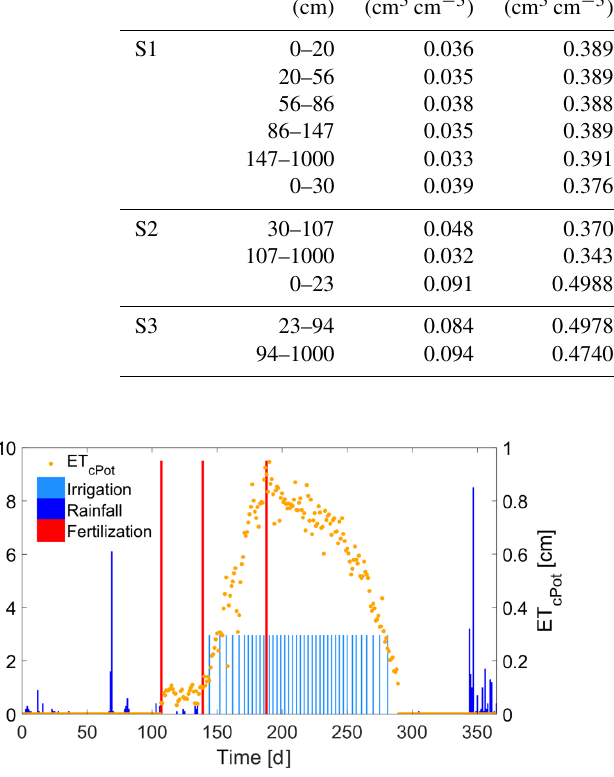
Table 4. Horizon depth, soil hydraulic properties and dispersity of each horizon, for the three different soil profiles assumed in this study. Soil type